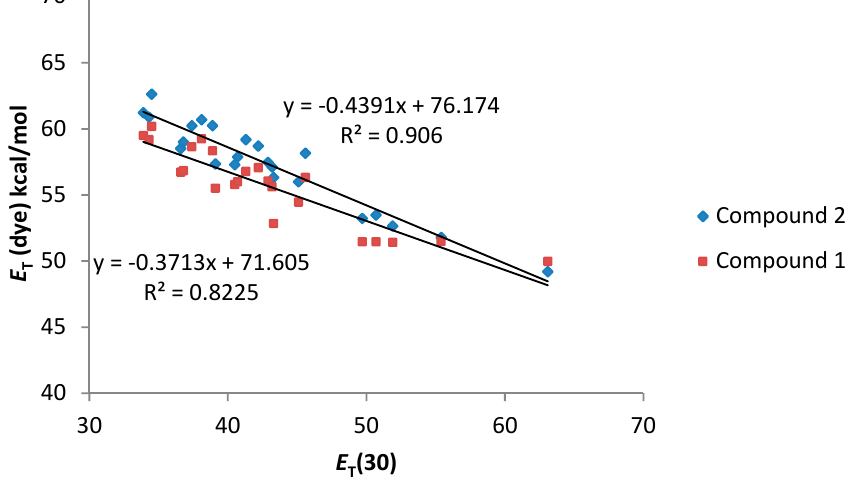
Figure 5. E T (dye) values (kcal · mol − 1 ) for compounds 1 and 2 vs. E T (30) solvent polarity parameter.